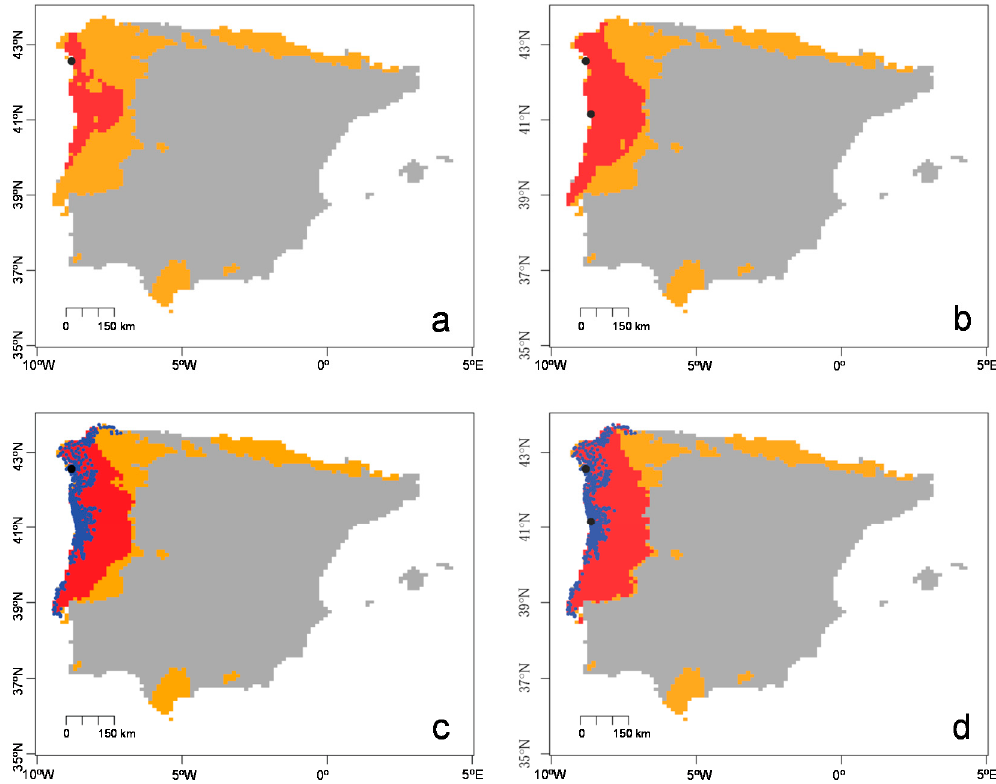
Figure 4. Predicted area invaded by Trioza erytreae using kernel models in a pest risk analysis framework. ( a ) Prediction for three years and one entry point. ( b ) Prediction for three years and two entry points. ( c ) Prediction for five years and one entry point. ( d ) Prediction for five years and two entry points. Orange areas represent favorable habitat suitability. Red areas represent invaded areas. Black dots represent entry points. Blue points represent the occurrence of T. erytreae . Results are shown for mainland Portugal and Spain and the Balearic islands.